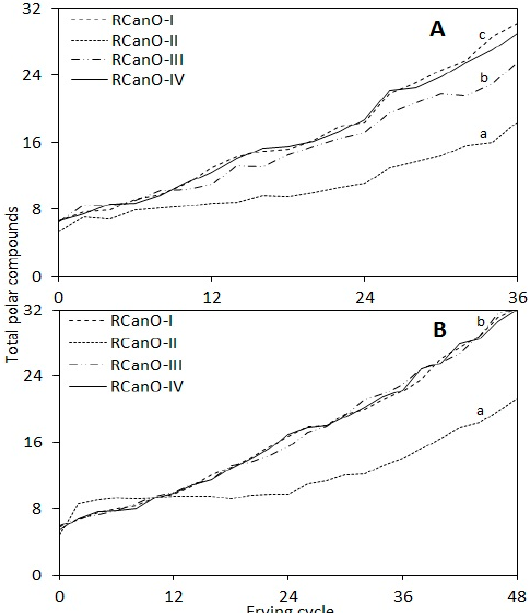
Figure 2. Changes in total polar compounds of canola oils during 36 and 48 frying cycles: ( A ) 2016/2017 ( n = 36) and ( B ) 2017/2018 ( n = 48) production seasons. Different letters show means that are statistically significant from each other ( p < 0.05).